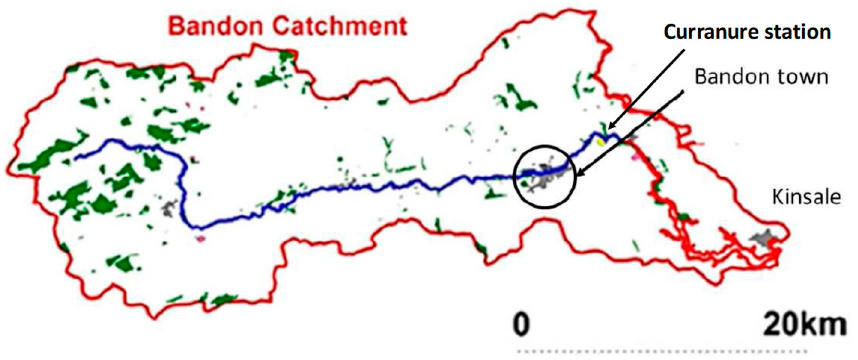
Figure 1. The River Bandon catchment and location of the Curranure gauging station.